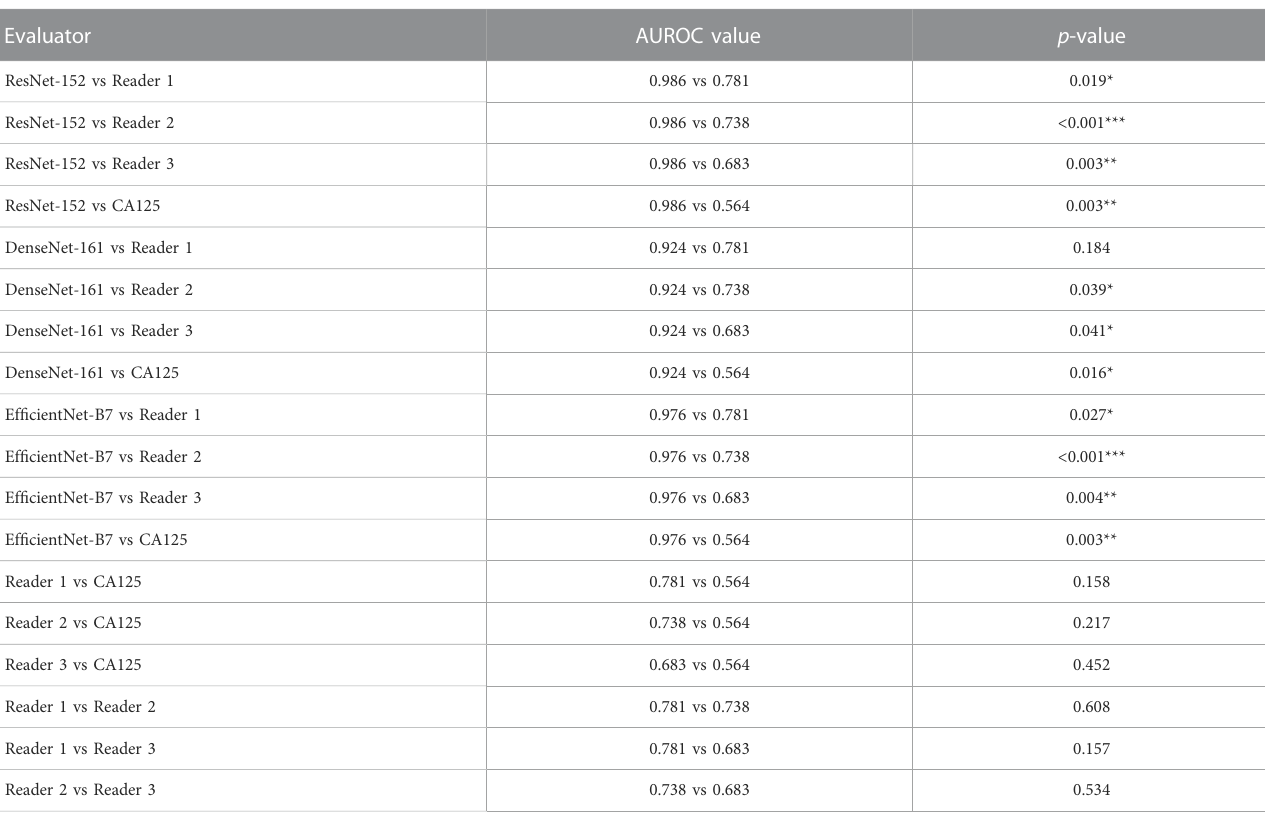
highly predictive, and the blue area represents low predictability. The deeper the color is, the higher will be the probability of being the discriminative region.